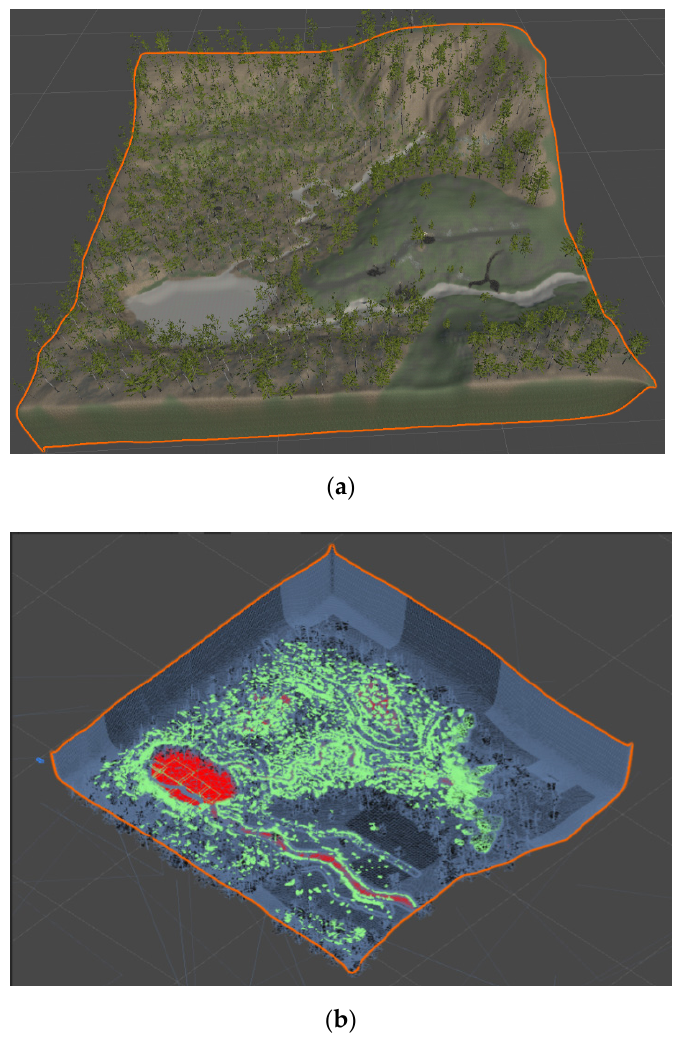
Figure 1. Nature Manufacture asset. ( a ). Original environment of Nature manufacture asset. ( b ). Nature Manufacture asset base on an albedo validate renderer.